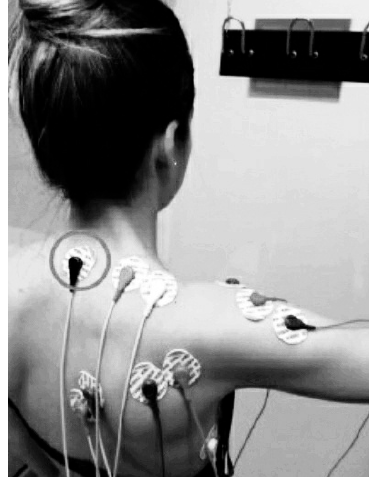
Figure 1. Posterior view of electromyography electrodes position during isometric shoulder abduction contraction. The reference electrodes are indicated with a circle. Image of Prieto Gómez reproduced with permission of the participant; 2019.